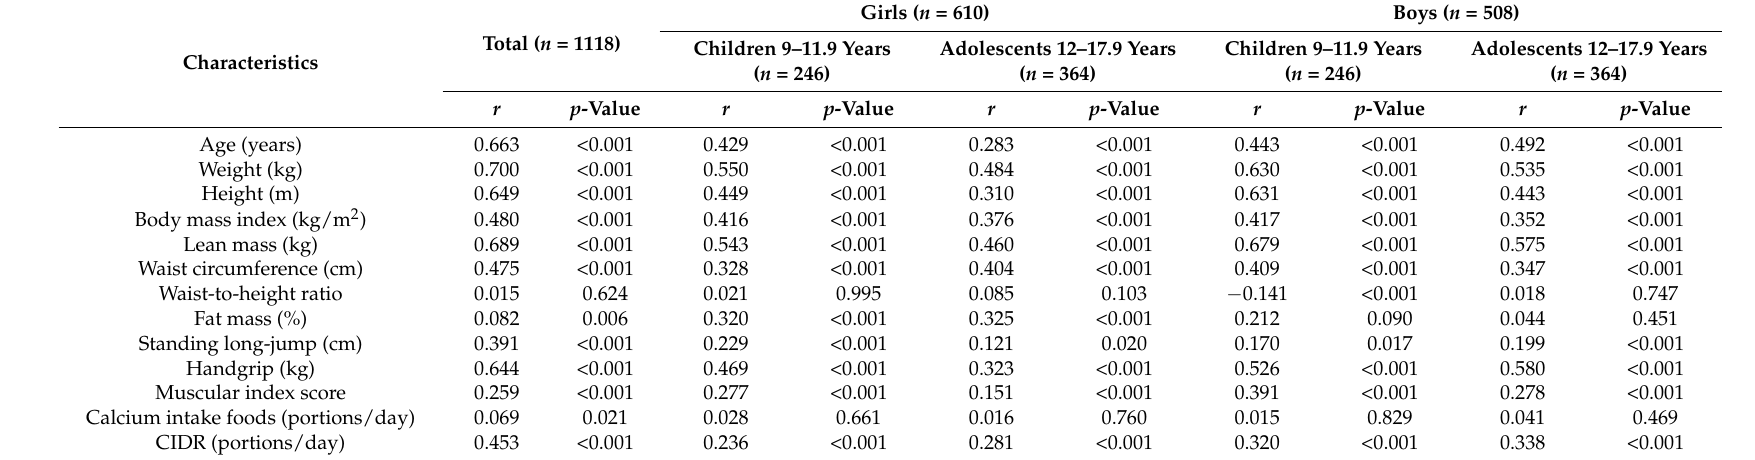
Table 2. Pearson correlation matrix for c-BUA and anthropometric, body composition, muscular fitness and calcium intake characteristics.